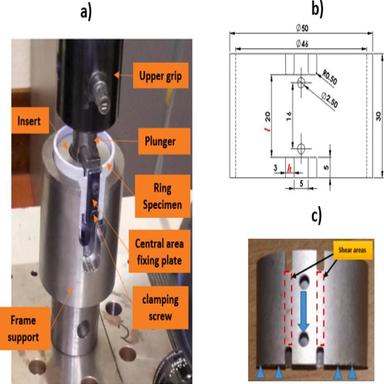
The ring hoop shear test: (a) loading device; (b) engineering drawing of the ring specimen; (c) RHST specimen, where the shearing areas are displayed.